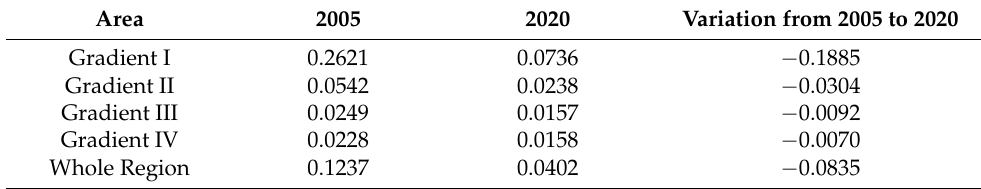
Table 4. Variations of habitat quality in the study